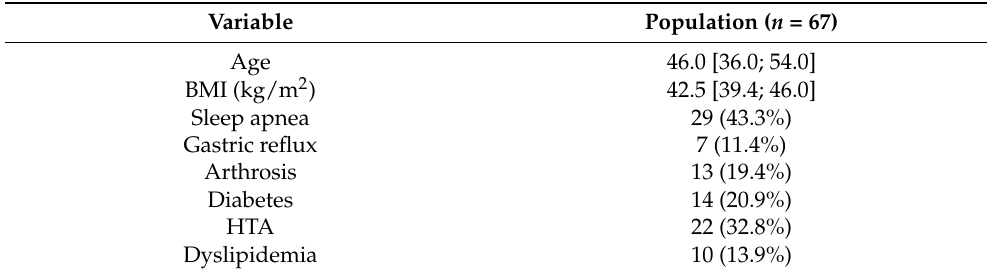
Table 1. Study population (number of patients ( N ), mean +/ − standard deviation, minimum, first interquartile, median, third interquartile, maximum).